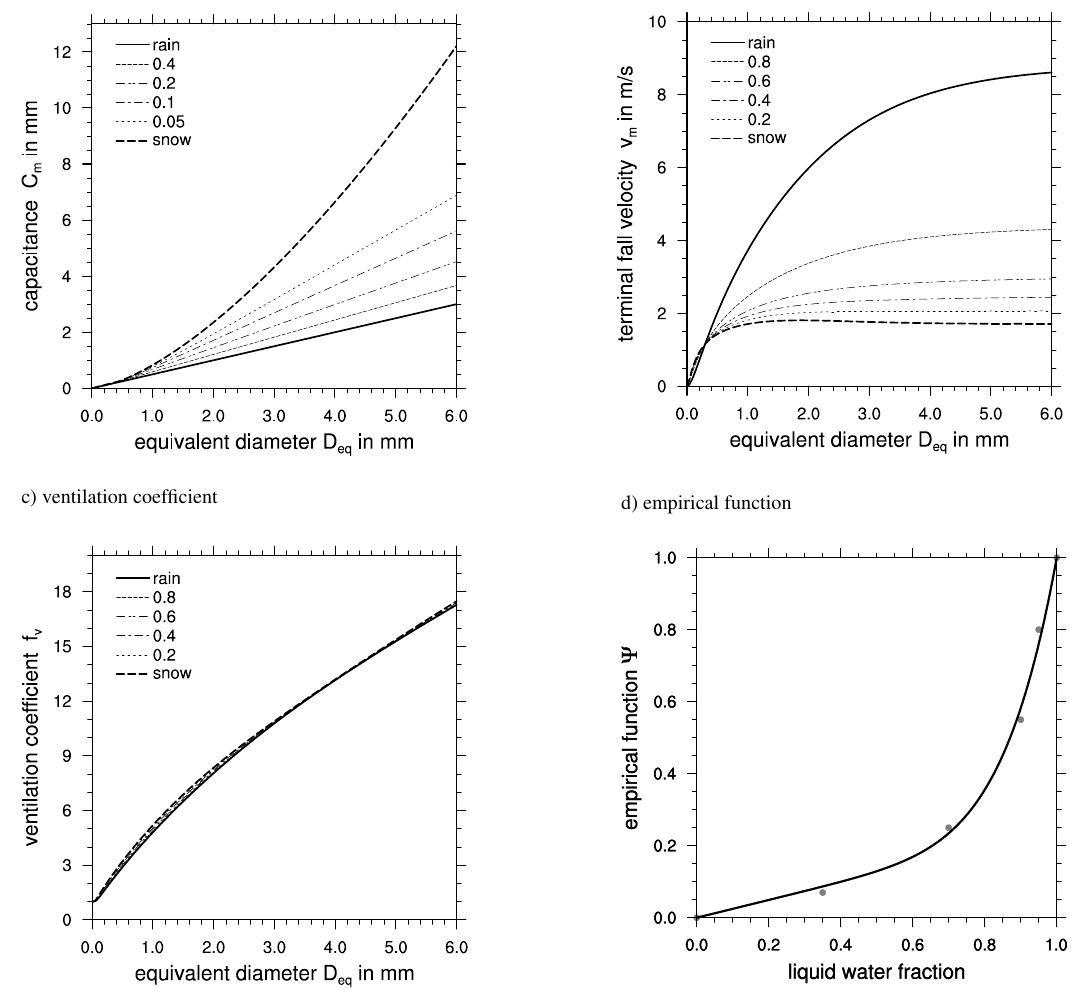
Fig. 1. (a) Capacitance, (b) fall velocity, and (c) ventilation coefficient of a melting snowflake as a function of the equivalent diameter for various values of ‘ . Rain and snow correspond to ‘ = 1 and ‘ = 0, respectively. (d) Empirical function 9(‘) that describes the transition between the fall speed of a snowflake and a raindrop. Shown are the approximate relationship Eq. (15) and the original data (grey dots) of Mitra et al.